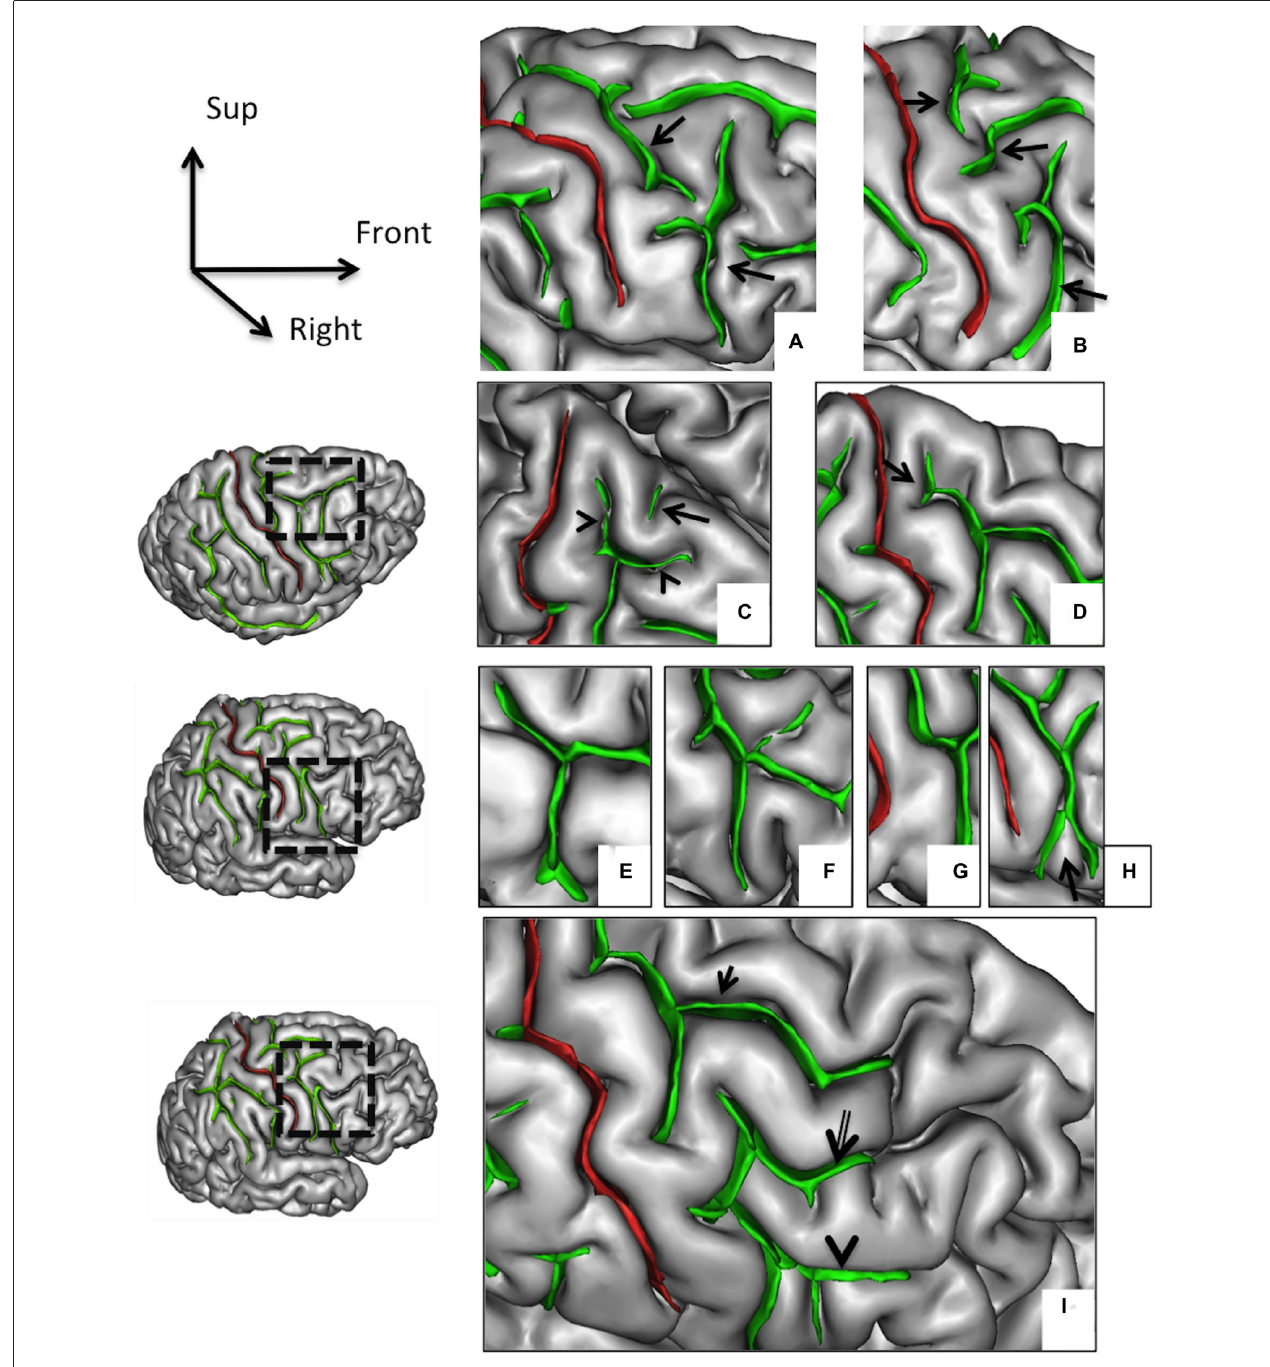
FIGURE 2 | Morphological features of the precentral sulcus (PreCS) with an excellent inter-rater concordance ( κ > 0.80) and with values (frequency occurrence) that do not differ from Ono’s post-mortem values. The PreCS (in green) represented on a 3D mesh-based reconstruction of the cortex surface. PreCS with two (A) or three (B) segments (arrows). PreCS superior end patterns (C) with marginal PreCS (arrow heads) and medial PreCS (arrow). PreCS superior segment shape with arcuate termination with Y-shaped end ( D , arrow). Pre-CS inferior segment patterns with arcuate form (E) , ramified form (F) , bayonet form (G) and Y-shaped end ( H , arrow). PreCS connections (I) with superior frontal sulcus (arrow), intermediate frontal sulcus (double arrow) or inferior frontal sulcus (arrow head).